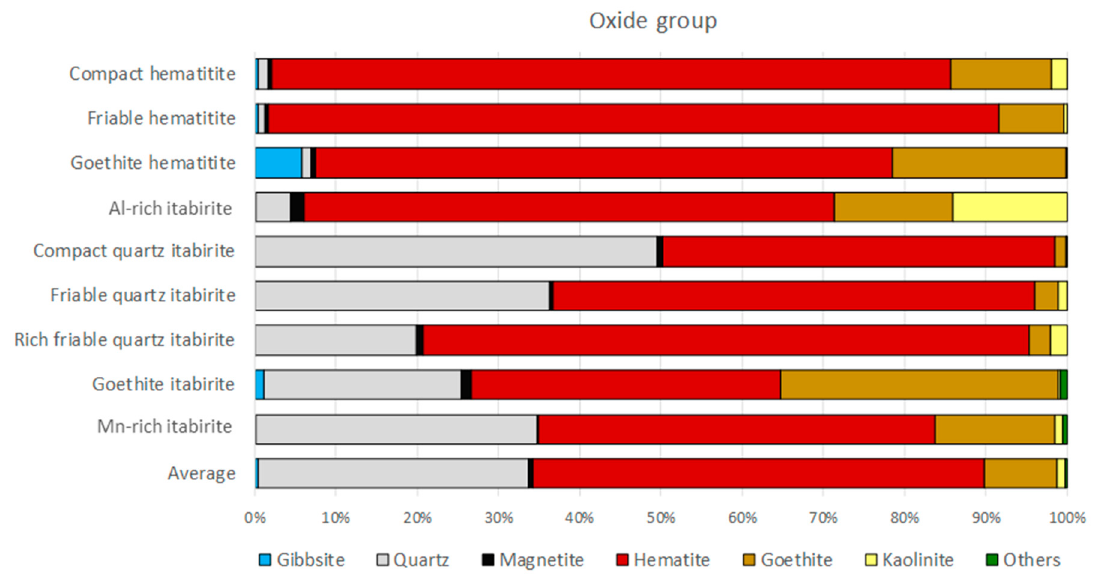
Figure 7. Average mineral proportions (wt. %) by XRD/Rietveld—weathered materials.